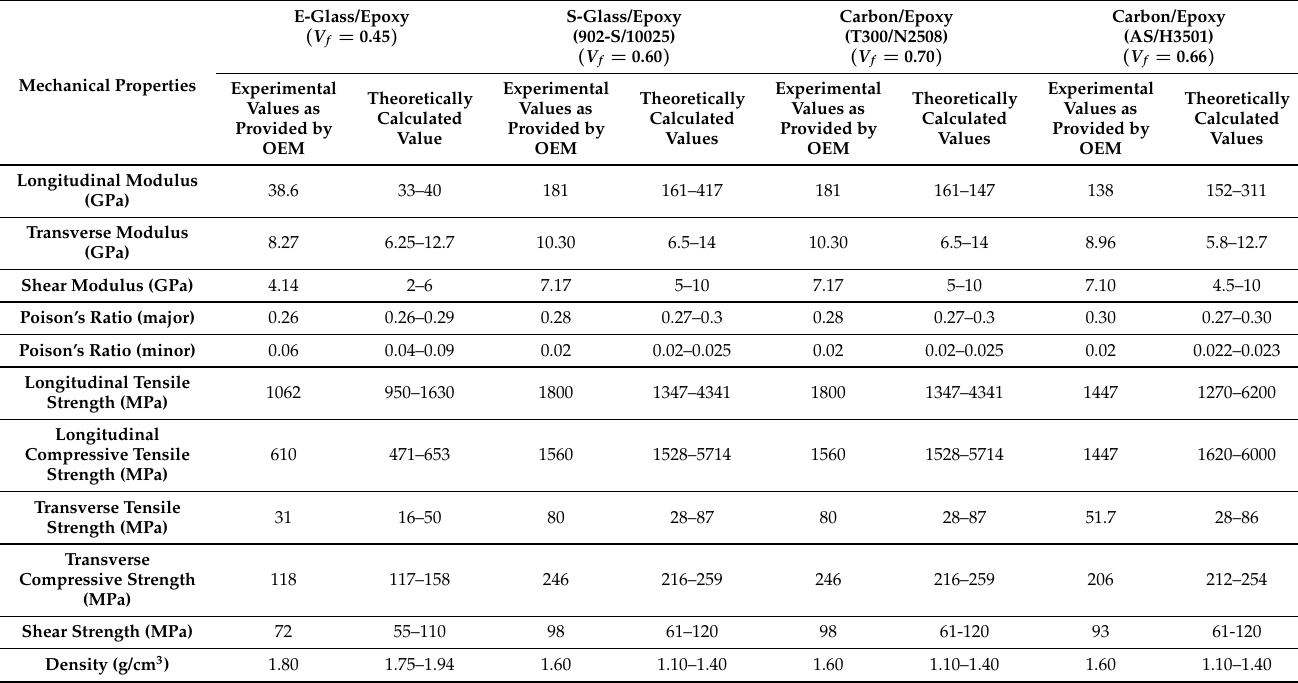
Table 2. Comparison of theoretically calculated and experimentally calculated properties of compos- ite